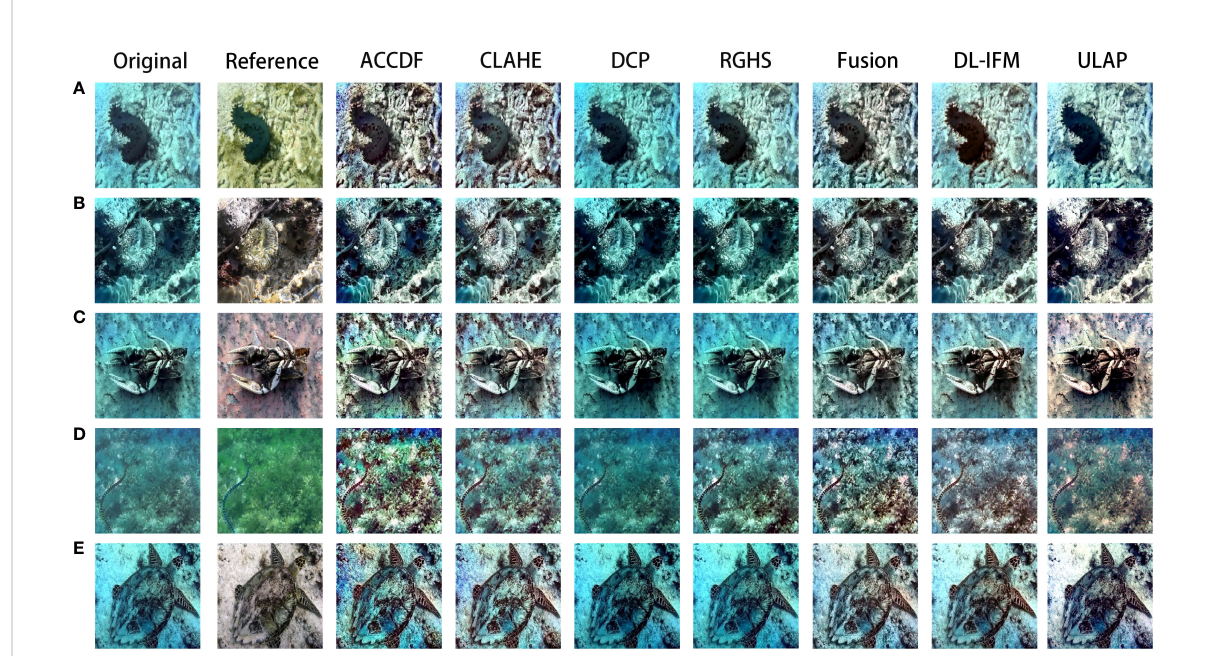
FIGURE 16 Image (A – E) are fi ve images selected from the EUVP dataset. From left to right are the original image, the ground truth image and the image processed by ACCDF, CLAHE, DCP, RGHS, FUSION, DL-IFM and ULAP